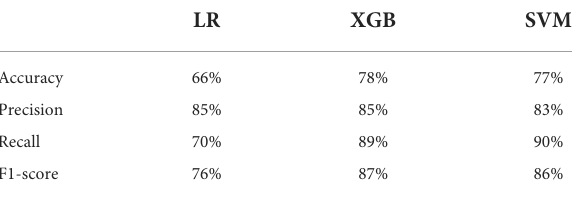
TABLE 4 Accuracy, precision, recall, and F1 score for each